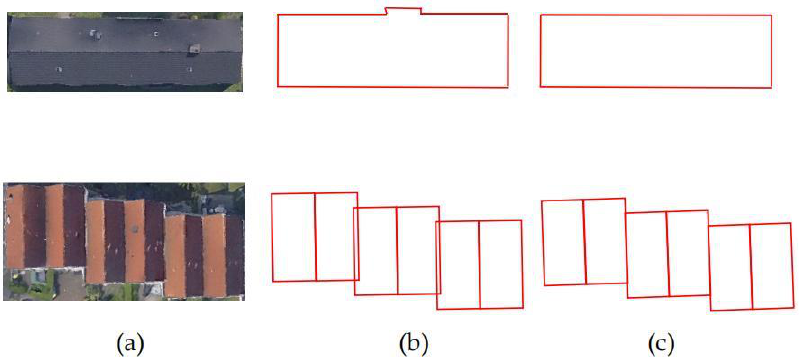
Figure 9. The example of the footprint modification: ( a ) DOM of buildings; ( b ) original footprint data; ( c ) modified footprint. Table 1. Detailed information of the oblique images.